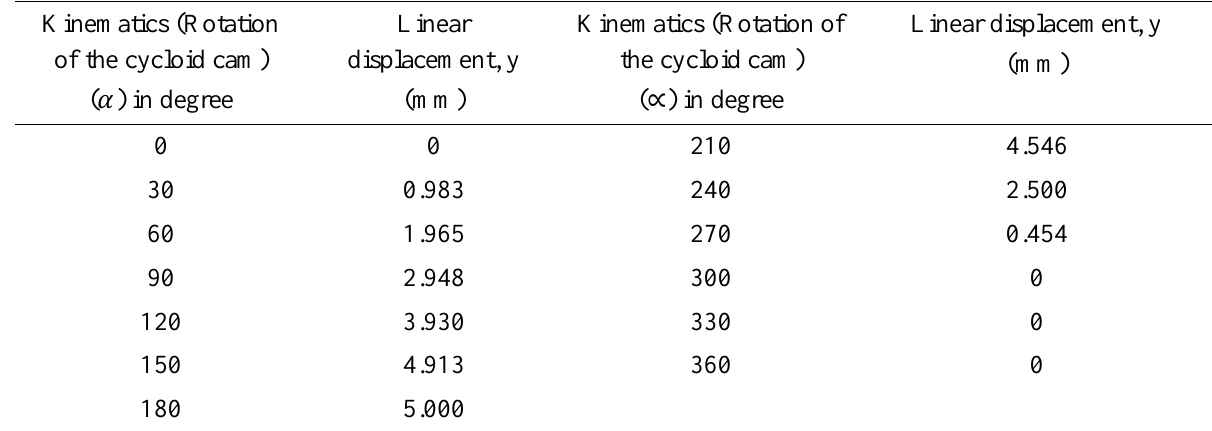
Table 5. The theoretical displacement of the cam from the circumference of the base circle to its profile (the kinematic motion of the follower during the rotation of the cycloid cam) for cam of maximum displacement (H), 5 mm from the base circle of the cam